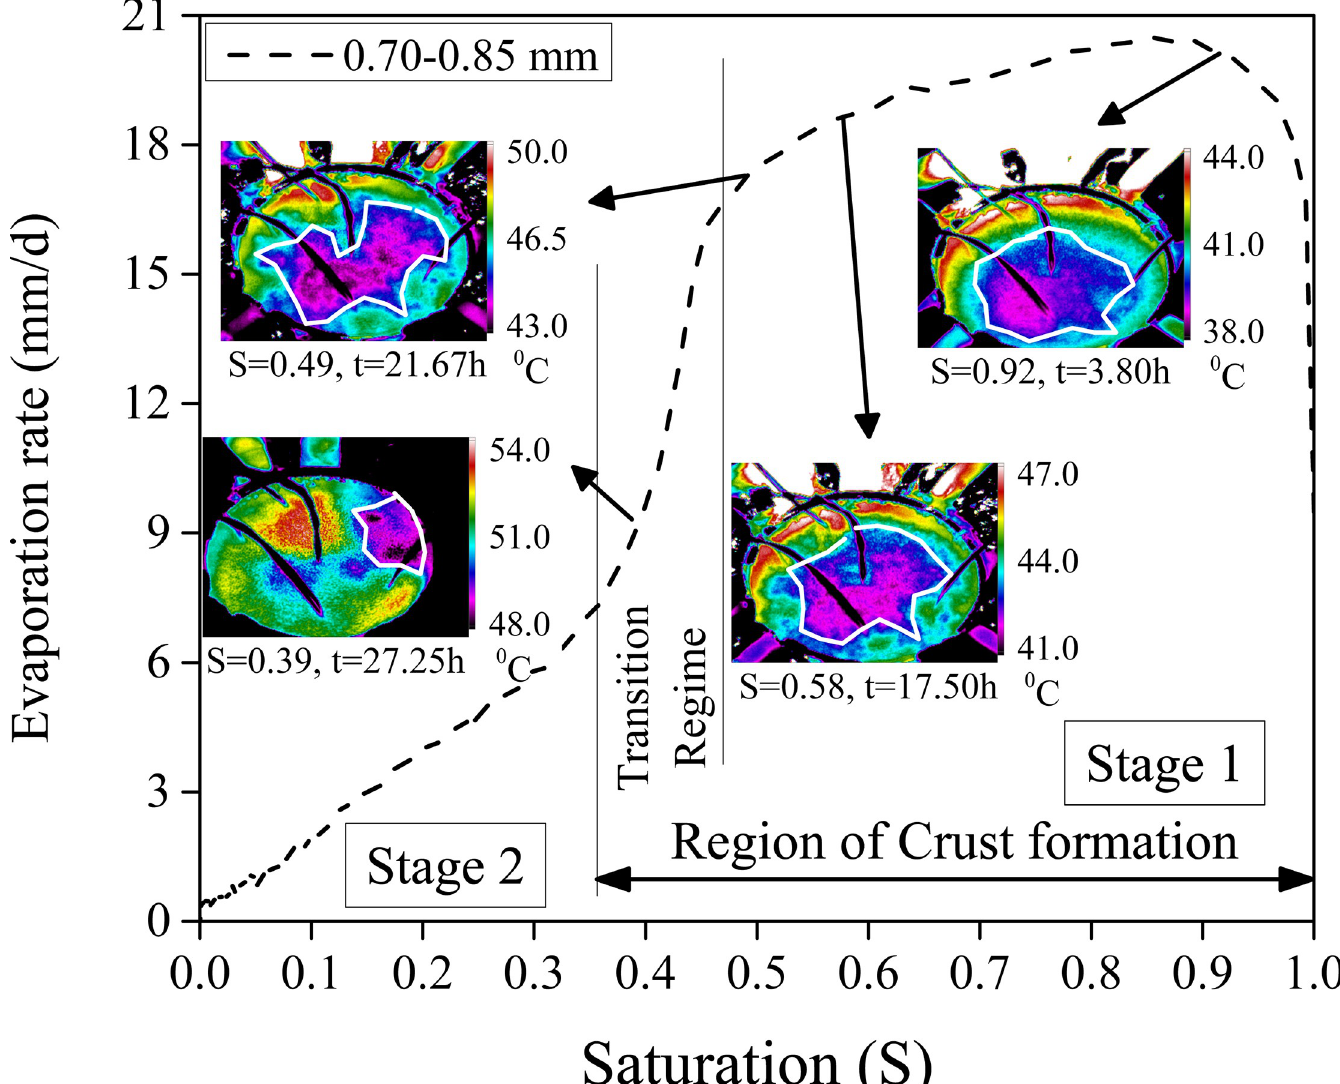
Fig 2. Rate of evaporation versus the saturation (S) for the case of 0.78 mm diameter (hydrophilic) glass beads. The experiment is the same as in Fig 1. IR images corresponding to four important instants are also seen. White curved lines in the IR images represent the boundary between the completely wet (inner) and the completely dry regions on the surface of the porous medium. Also mentioned are the temperature scales for the IR